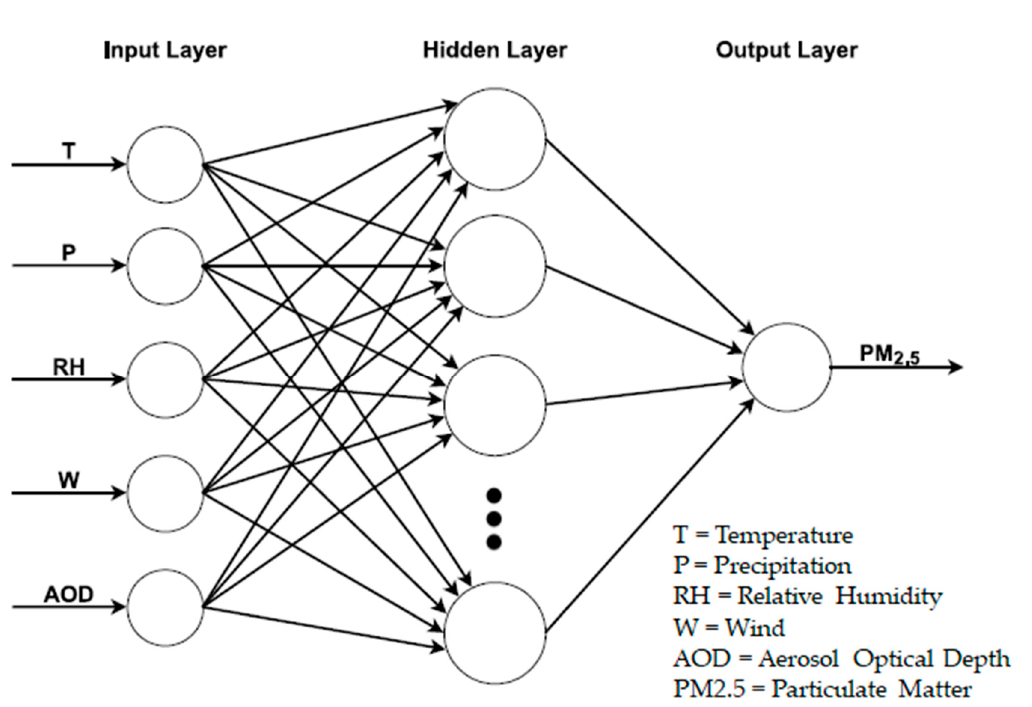
Figure 4. Schematic view of a feed-forward artificial neural networks.